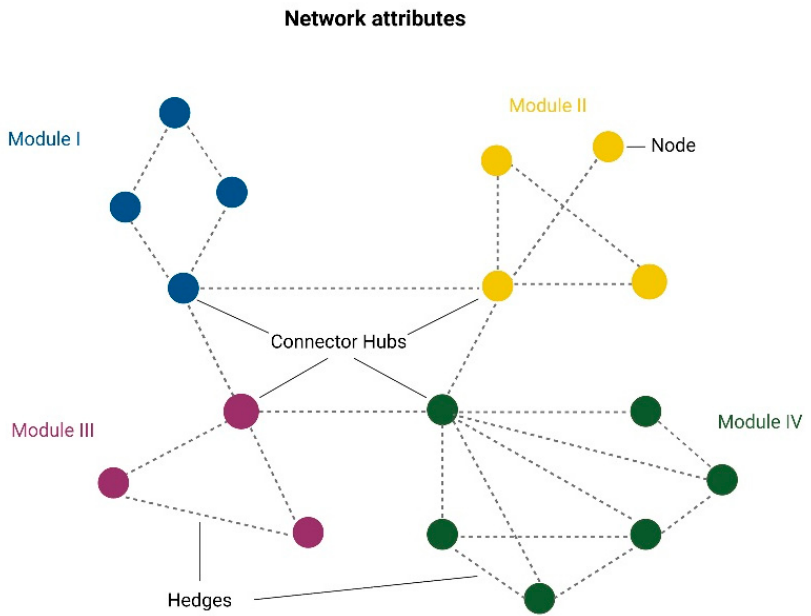
Figure 2. Graphical representation of network attributes. The circles indicate nodes; the nodes of the same color are grouped into modules; the dotted lines represent the hedges. Please, see the corresponding text for a full acknowledgment of network properties. Created with BioRender.com, accessed on 24 November 2022